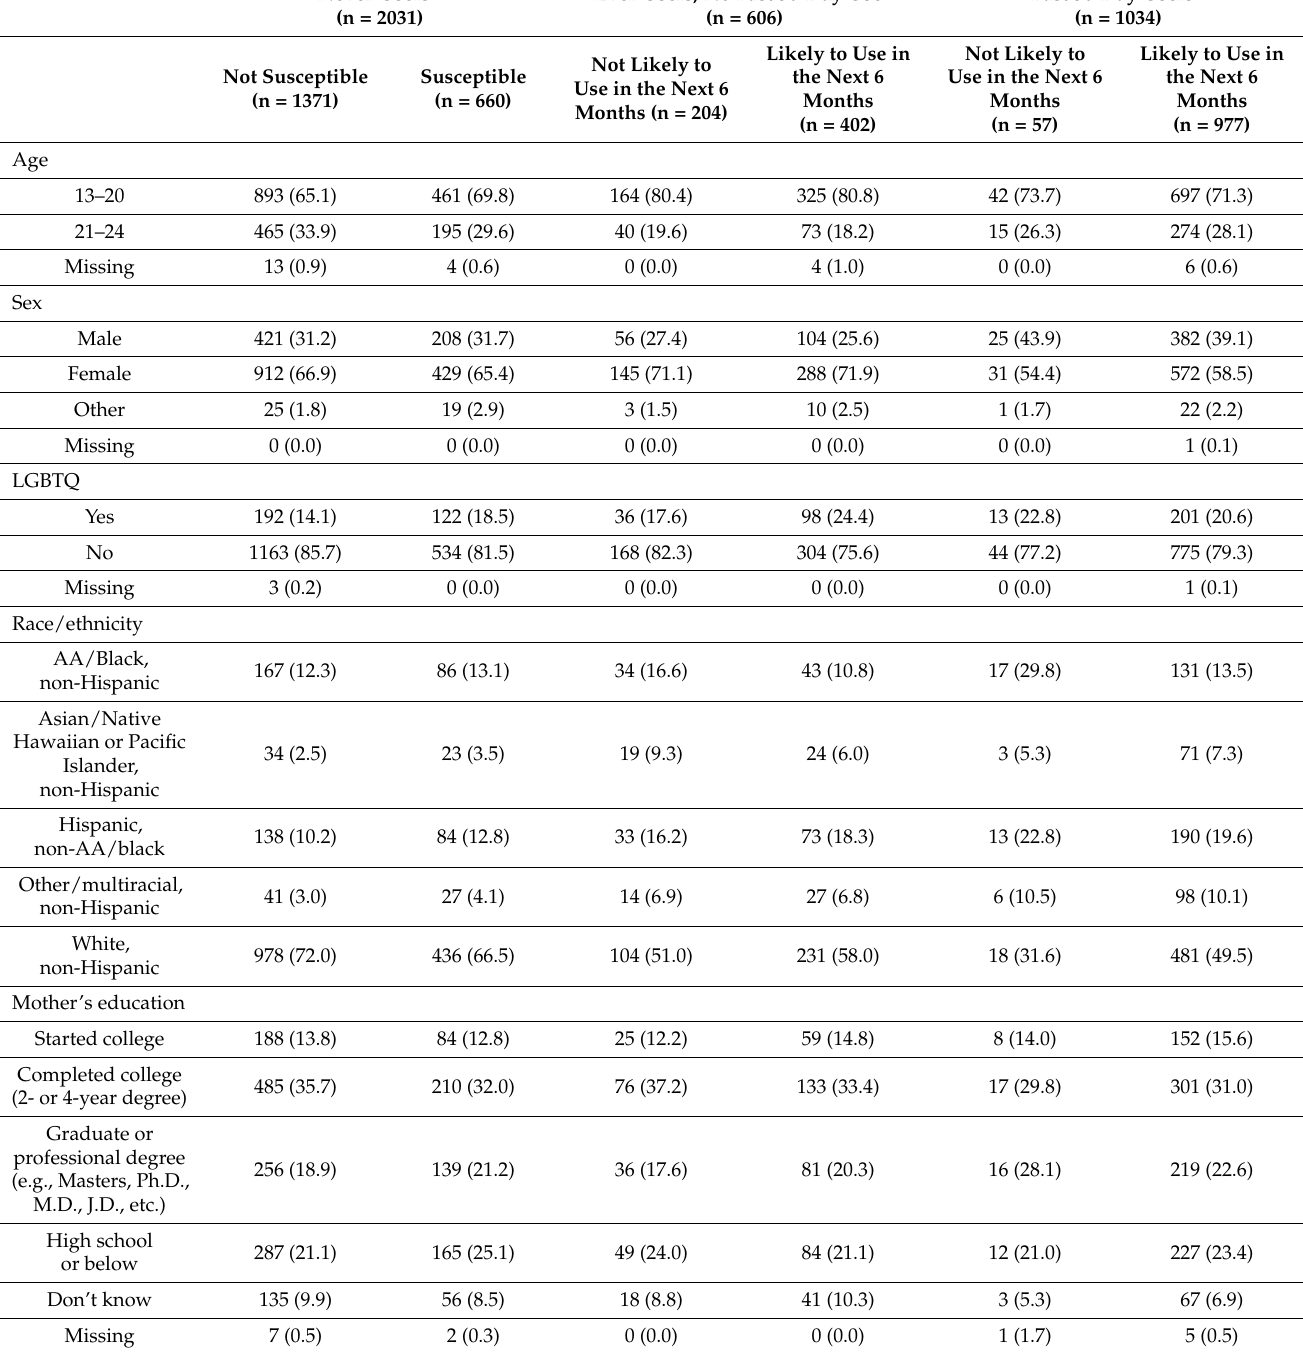
Table 1. Participant characteristics by susceptibility among never-users and intended future use among ever-users and past-30-day users (n, unweighted